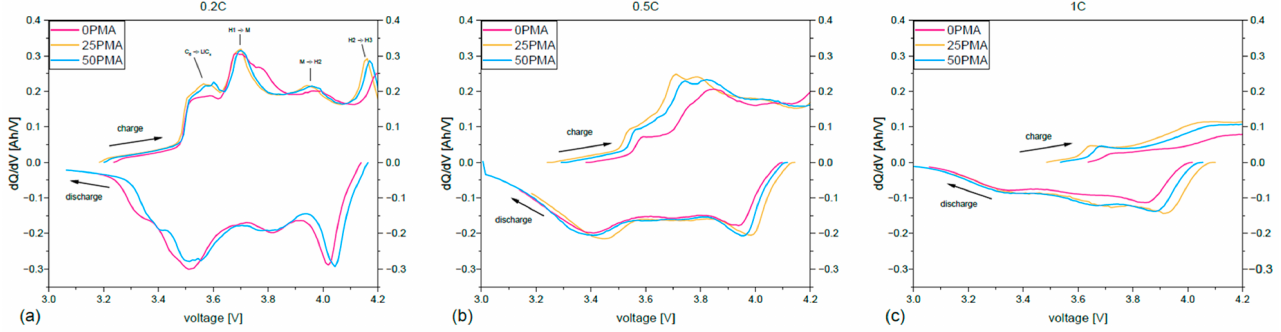
Figure 7. Differential plots for ( a ) 0.2C, ( b ) 0.5C, and ( c ) 1C.